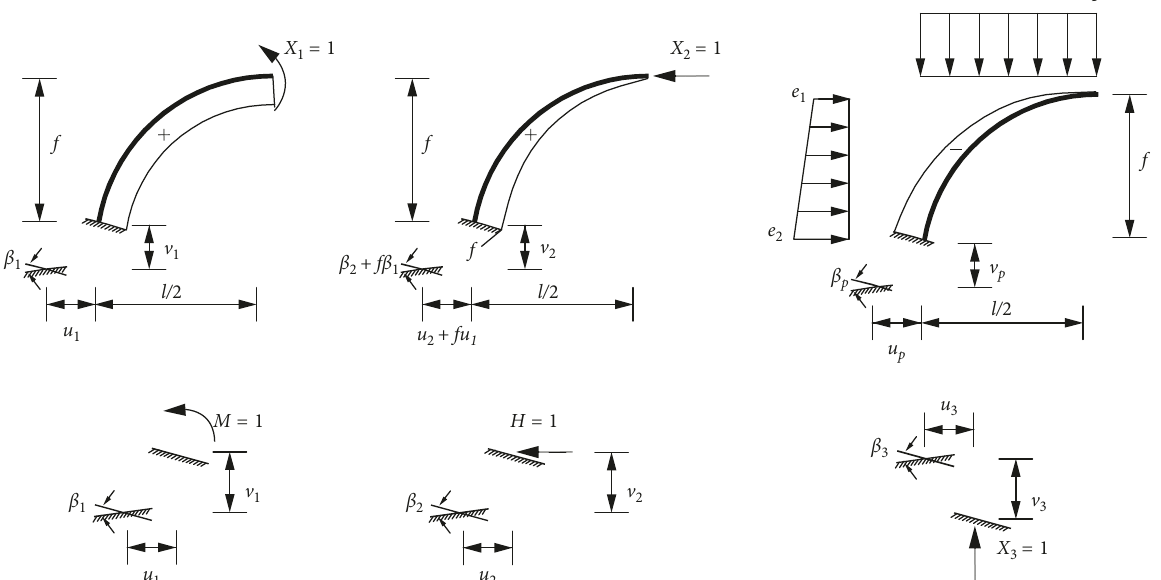
Figure 6: Displacements at the foot section of the steel rib caused by the unit forces acting at the arch foot section and crown